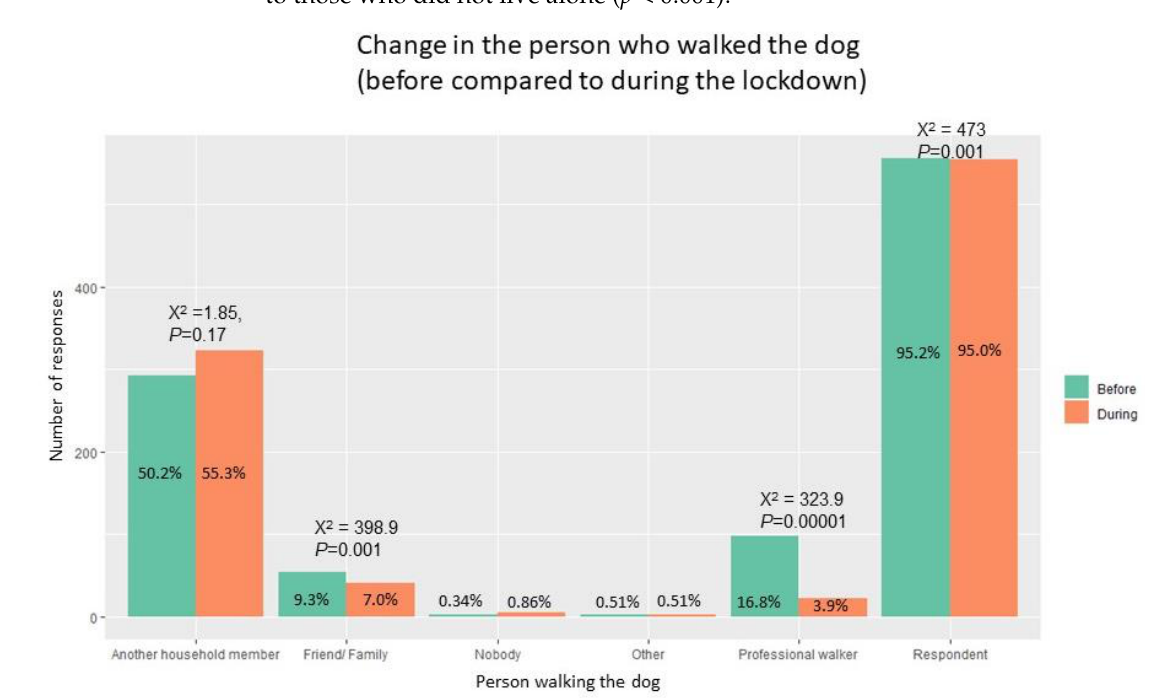
Figure 2. Person who walked the dog before and during the pandemic lockdown (McNemar’s X 2 and p -value are provided where the sample size permitted a meaningful comparison).